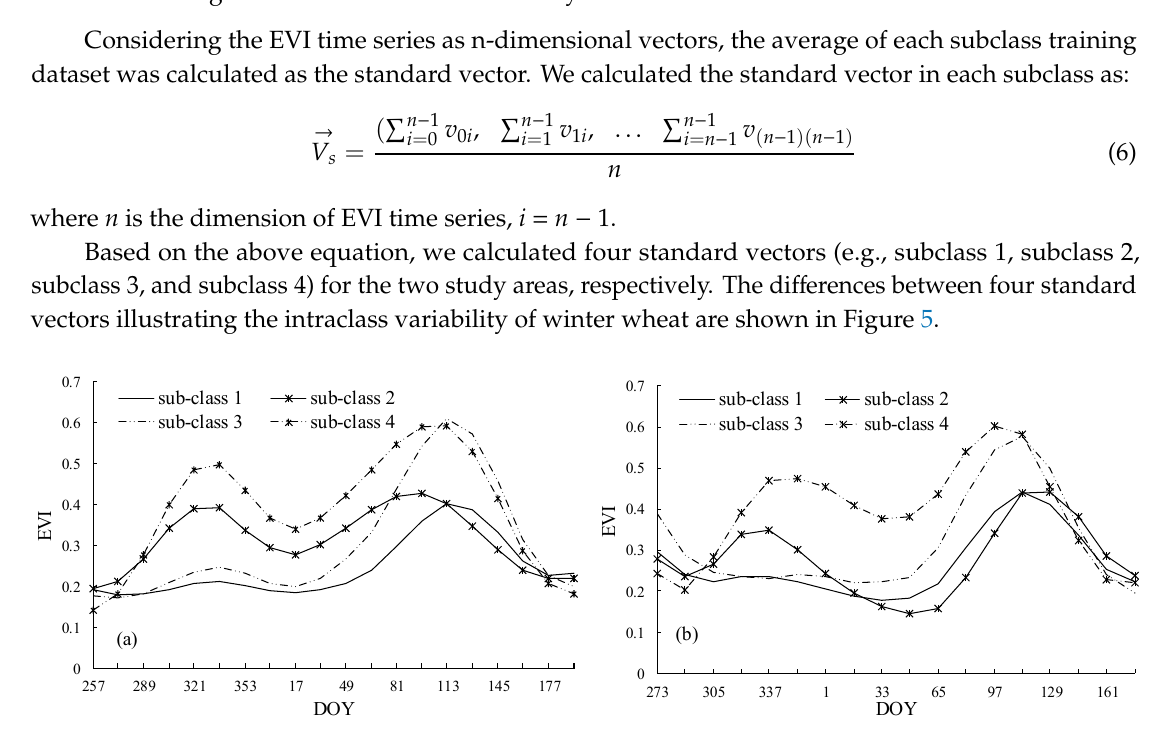
Figure 5. Four standard vectors in Kansas (a) and the NCP plain (b).